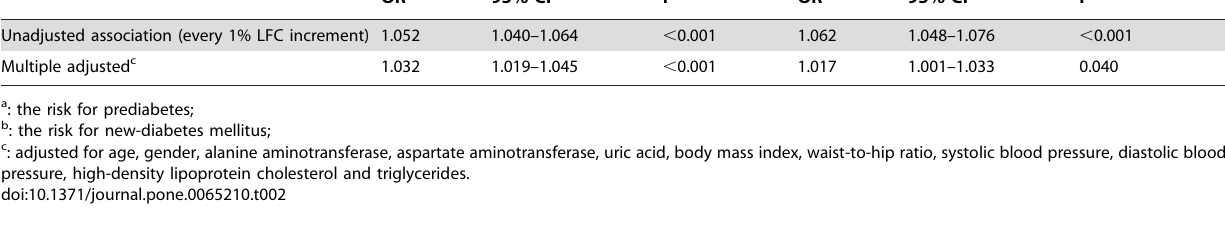
OR a 95% CI a P a OR b 95% CI b P b Unadjusted association (every 1% LFC increment)